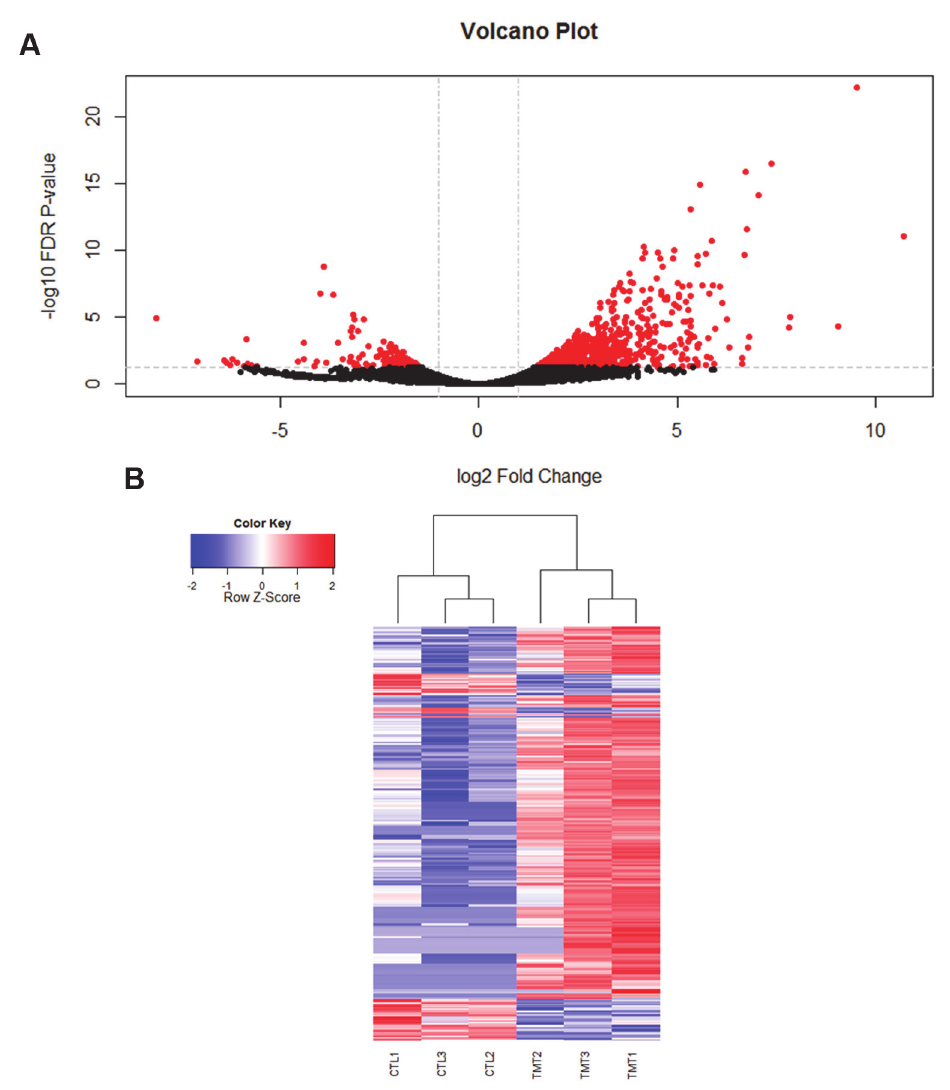
Fig 1. Viral infection with IAPV alters gene expression patterns in honey bee fat bodies. A) A volcano plot was created to visualize the amount of significantly differentially expressed genes. The horizontal line represents an FDR p-value of 0.05 and the vertical lines represent a two-fold change in the log of the expression. The red circles indicate genes that are significantly differentially expressed in response to viral infection. 753 genes were found to be significantly differentially expressed (FDR < 0.05). B) A heat map of the log 2 transformed read counts for the 753 significantly differentially expressed genes was generated. Transcription levels were normalized using a TMM method. Red colors indicate higher levels of gene expression and blue colors indicated lower levels of gene expression relative to the average across the samples. Treatment and control samples are denoted by “ TMT ” and “ CTL ” respectively. The heat map was created with R statistical